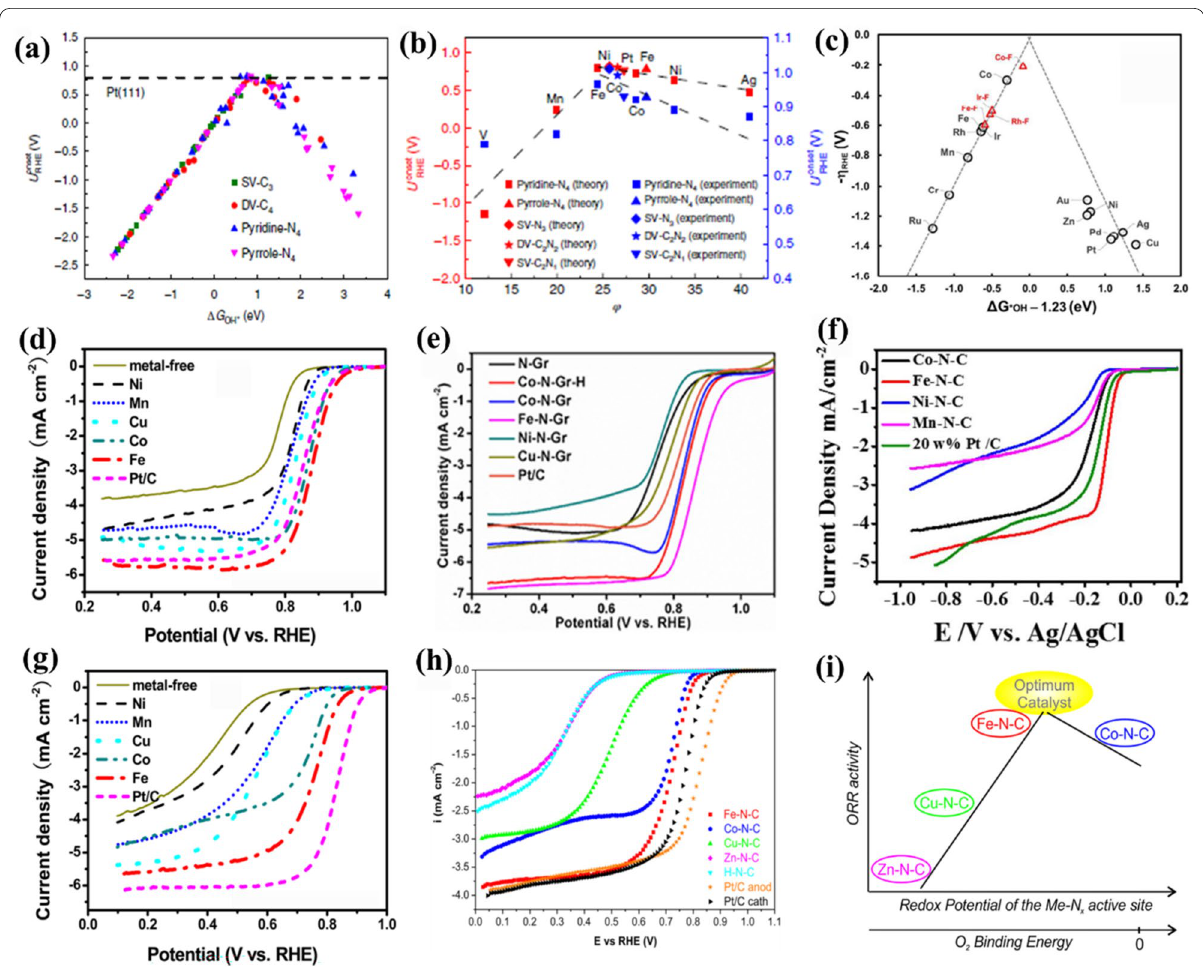
Fig. 2 a ORR theoretical onset potential versus Δ G OH* on carbon‑based SMACs with different metal atomic centers. b Theoretical and experimental ORR onset potentials versus the descriptor φ . c The trend in the theoretical ORR overpotential of metalloporphyrin‑based catalysts plotted against Δ G OH* 1.23 eV. d – f Linear sweep voltammetry (LSV) curves of carbon‑based SMACs with different metal atomic centers in O 2 ‑saturated 0.1 M KOH. − g LSV curves of carbon‑based SMACs with different metal atomic centers in O 2 ‑saturated 0.1 M HClO 4 . h LSV curves of carbon‑based SMACs